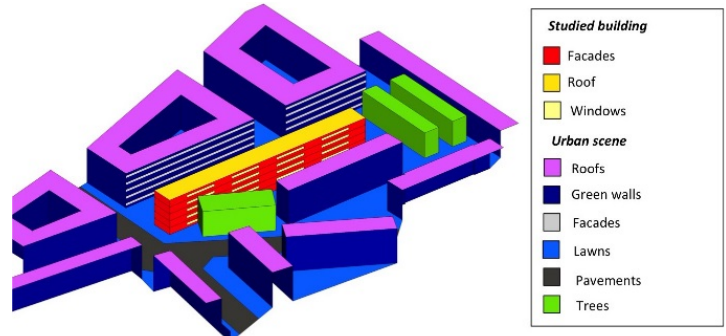
Figure 5. The various types of surfaces available for assignment.